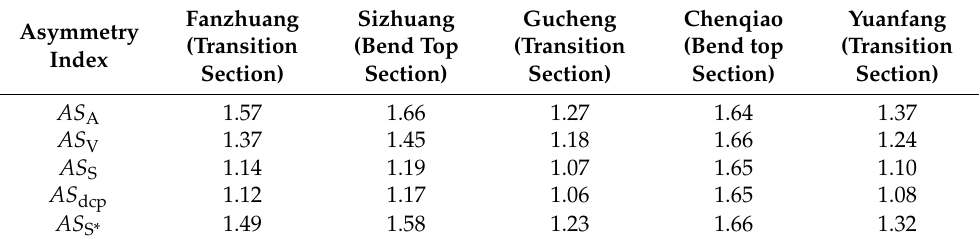
Figure 8. Wandering reach of the lower Yellow River (Fanzhuang–Yuanfang): ⑱ Liuyuankou ex- tension project ⑲ Dagong project ⑳ Wangan project ㉑ Gucheng project ㉒ Fujunshi project G. Fanzhuang section, H. Sizhuang section, I. Gucheng section, J. Chenqiao section, and K. Yuanfang section. Table 3. Asymmetry index of wandering river bend top and transition section (scouring and silting balance, S = 32 kg/m 3